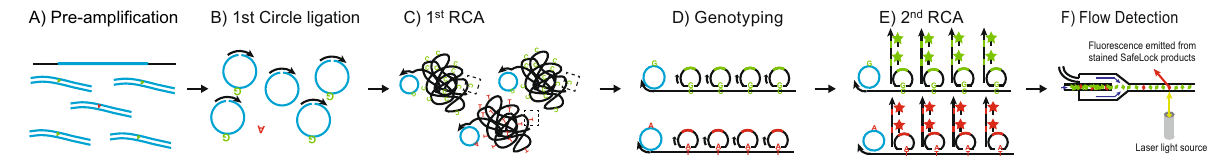
Fig. 1 Generation of superRCA ampli fi cation products. A DNA sequences of interest in a sample are ampli fi ed by PCR. B Ampli fi ed strands are converted to single-stranded DNA circles via templated ligation of their 5 ʹ and 3 ʹ ends. C Oligonucleotides that template the circularization reactions next serve as primers for RCA reactions. D The RCA products are then interrogated with padlock probes speci fi c for mutant or wildtype sequences. E Ligated padlock probes, wound around the RCA products, thereafter template secondary RCA reactions, primed by an added oligonucleotide. F For each starting DNA